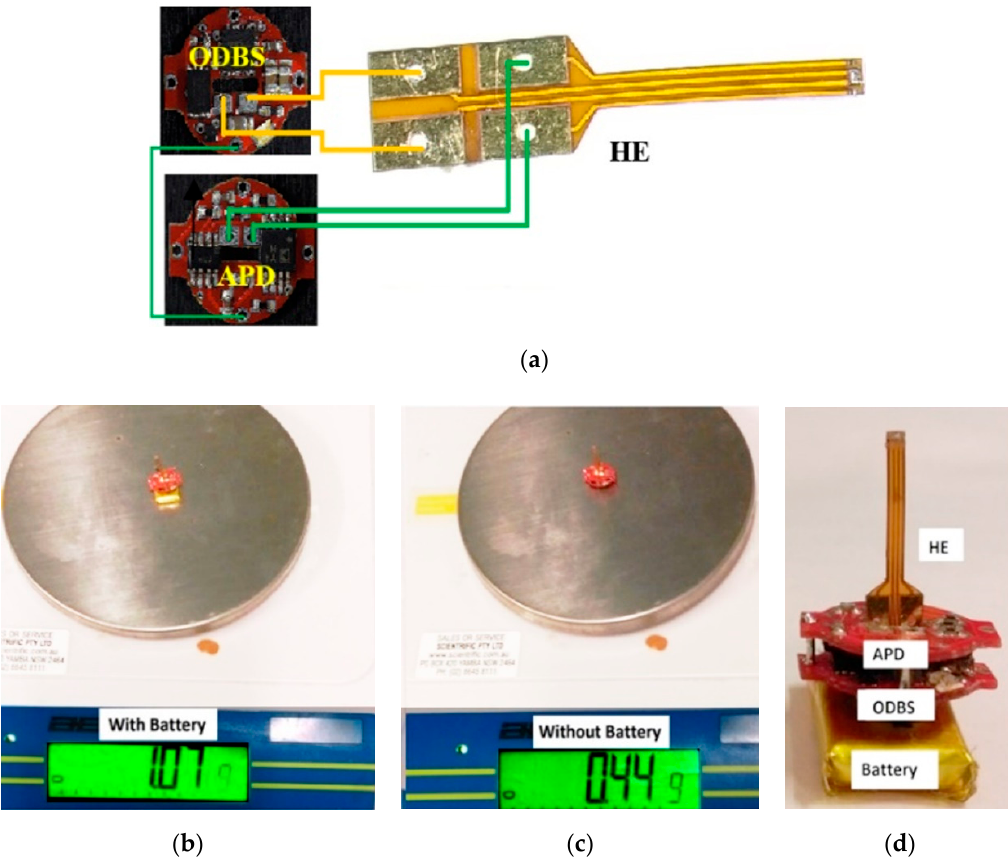
Figure 7. Closed-loop optogenetic stimulation (CLOS) device. ( a ) Connections between the hardware modules. ( b ) Weight of the device with battery. ( c ) Weight of the device without battery. ( d ) Integrated CLOS device.